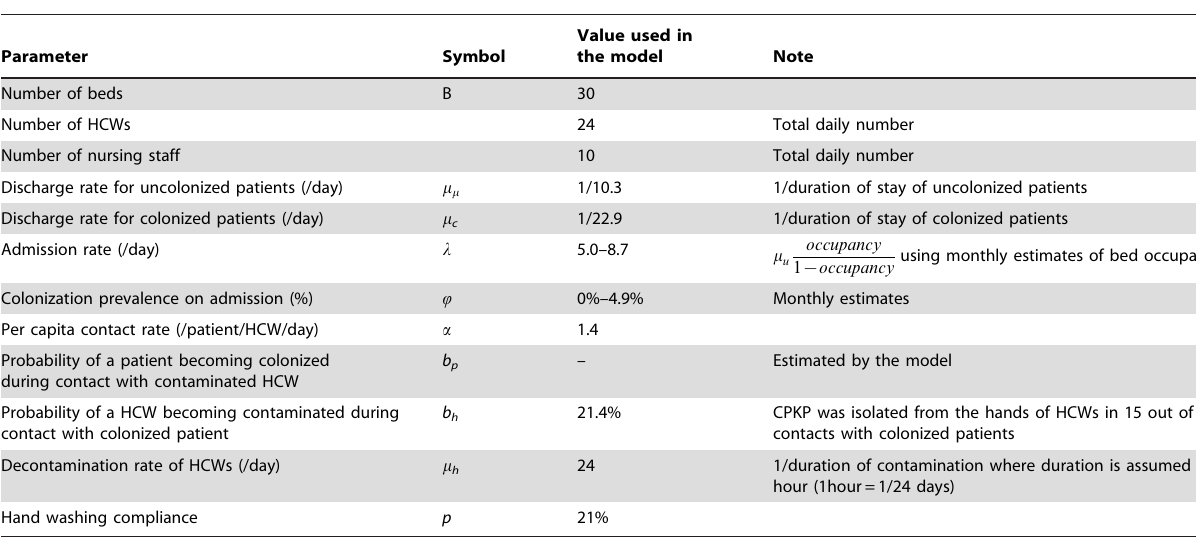
Table 1. Parameter estimates used in the model of CPKP